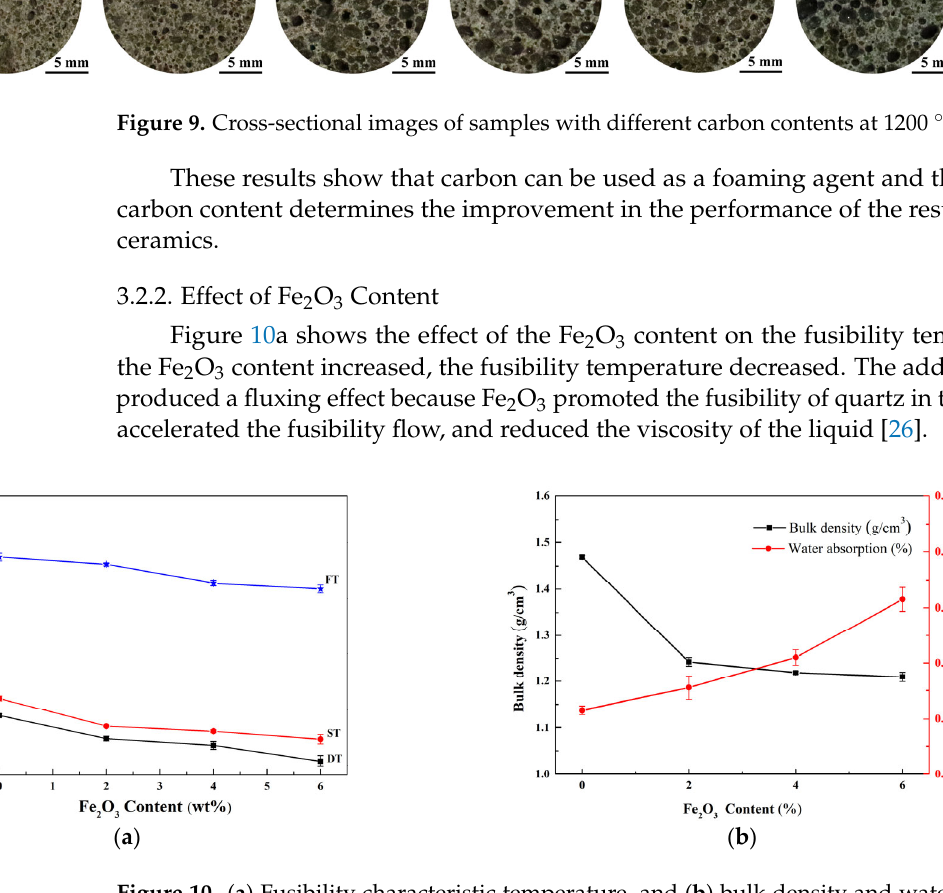
Figure 10. ( a ) Fusibility characteristic temperature, and ( b ) bulk density and water absorption of samples with different Fe 2 O 3 contents at 1200 ◦ C for 20